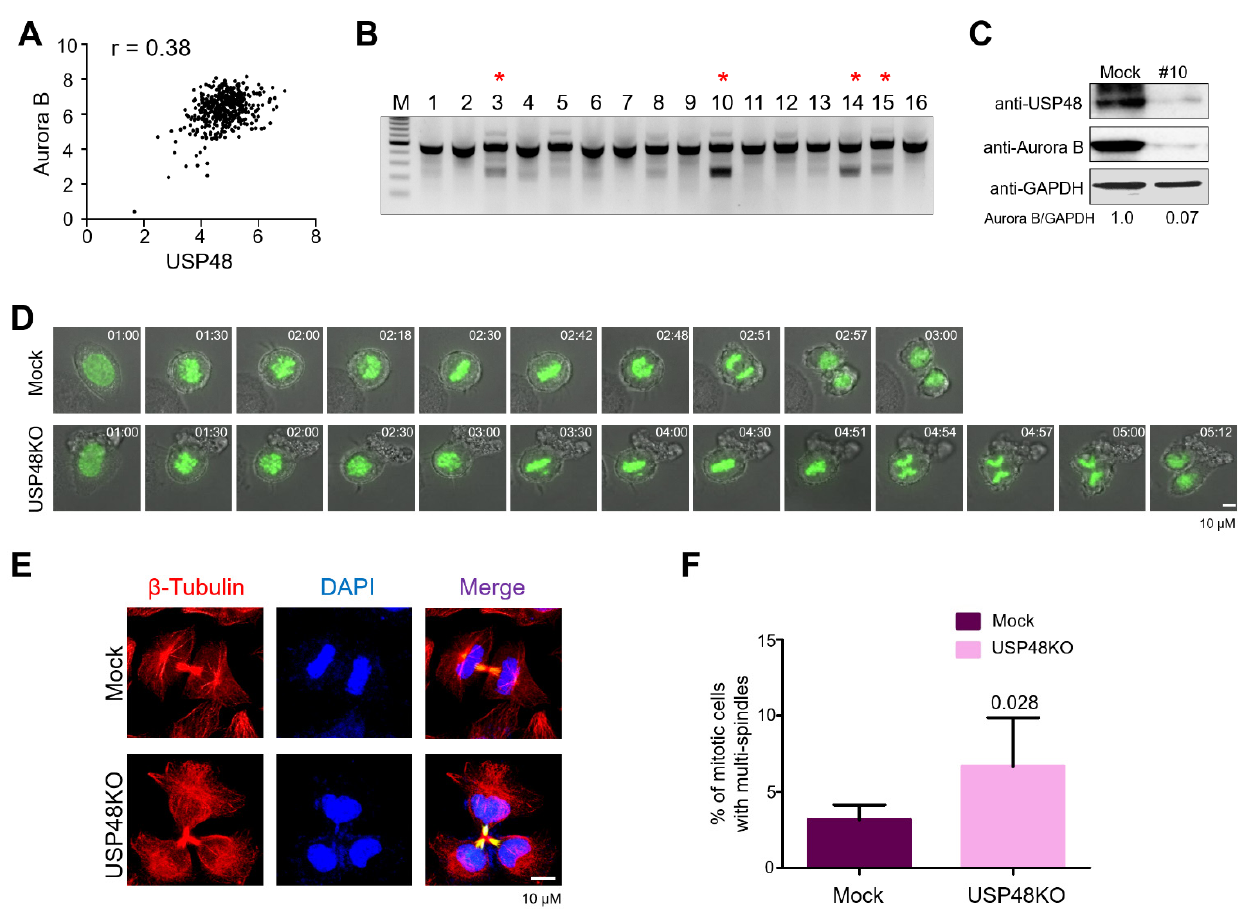
Figure 4. USP48 influences cell cycle progression. ( A ) A scatterplot demonstrating the correlation between USP48 and Aurora B mRNA levels was plotted. Pearson correlation analysis (r) was used to quantify the relationship between USP48 and Aurora B ( n = 455). ( B ) Single-cell-derived USP48KO colonies were screened using the T7E1 assay. Red asterisk represents the T7E1 positive USP48KO clones, i.e., USP48KO clones #3, #10, #14, and #15. ( C ) The effect of USP48 knockout on Aurora B protein expression was checked by Western blot analysis in USP48KO clone #10 upon M phase synchronization with 100 ng/mL Nocodazole for 18 h. GAPDH was used as a loading control. ( D ) Time-lapse microscopy of mock and USP48KO HeLa cells transfected with GFP-H2B and treated with thymidine and released into fresh medium to track cells undergoing mitosis. Time points are indicated in hh:mm format. Scale bar = 10 µM. ( E ) Microtubules were stained with β -Tubulin-Cy3 antibodies in mock and USP48KO HeLa cells. DAPI was used to stain the nuclei. Scale bar = 10 µM. ( F ) Graph representing the percentage of multinucleated cells in mock (3.166 ± 0.98), and USP48KO HeLa cells (6.667 ± 3.20) ( n = 3, p = 0.028 ) .